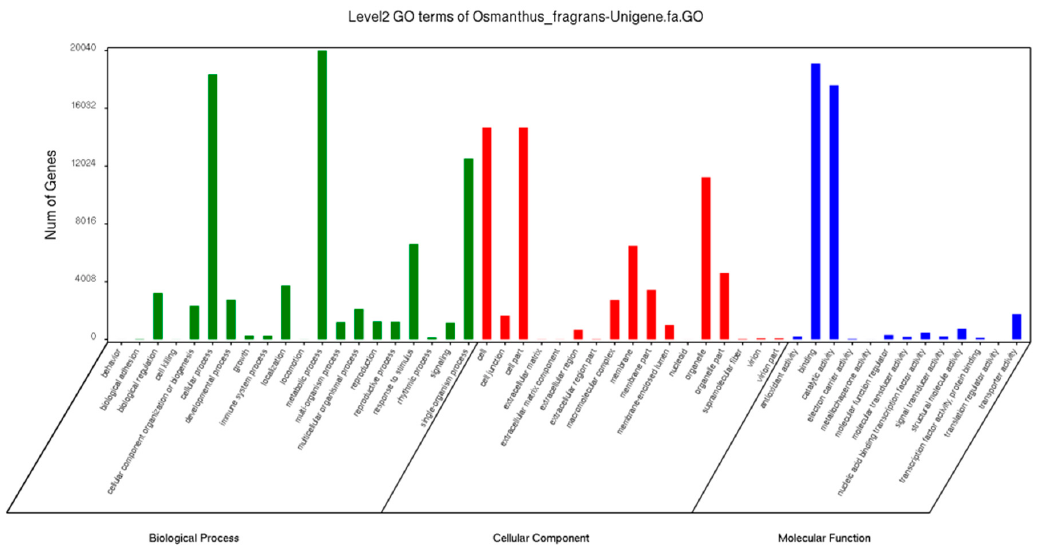
Figure 2. The GO functional classification of differentially expressed genes (DEGs) among different